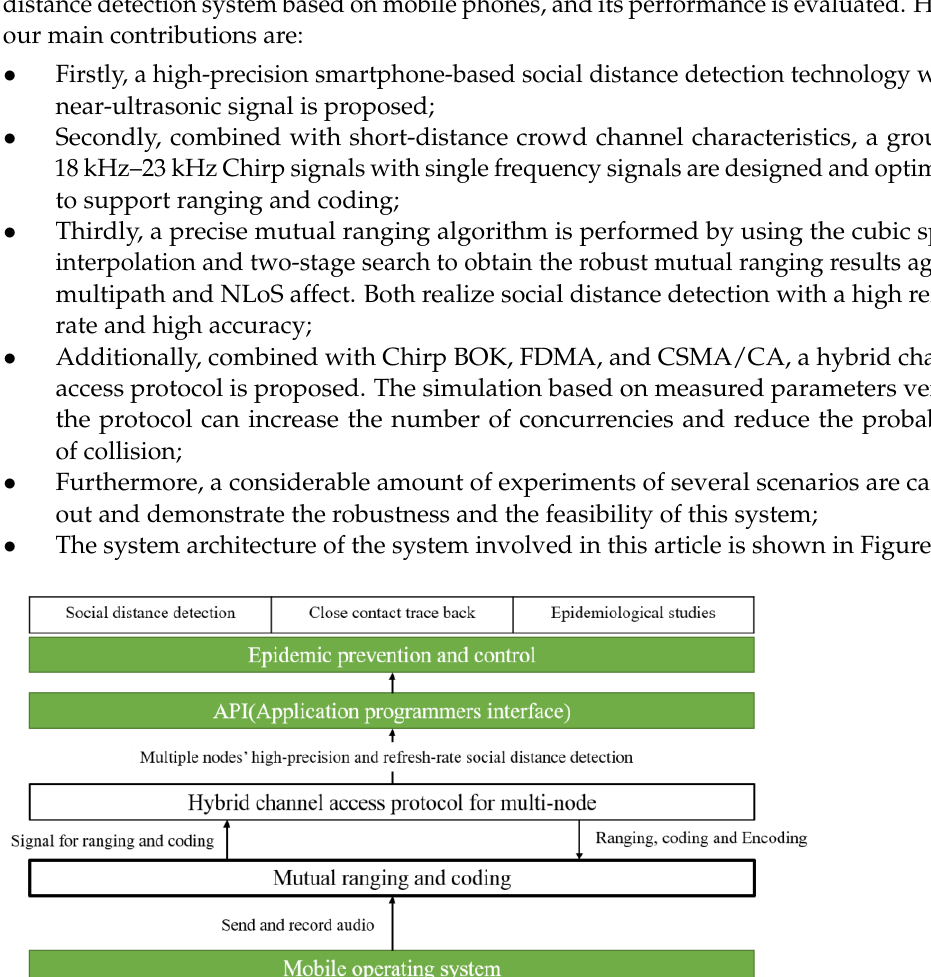
Figure 1. The structure of BeepBeep.